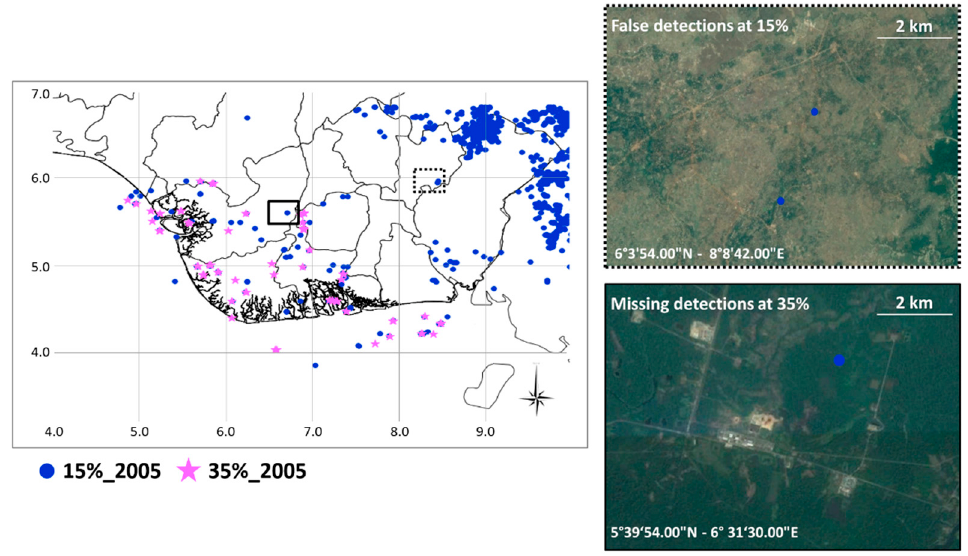
Figure 3. Flaring sites detected by RST-FLARE in 2005 for a temporal persistence percentage of 15% (blue dots) and 35% (pink stars). On the right a detail of false positives ( top ) and missed detections ( bottom ) are shown.